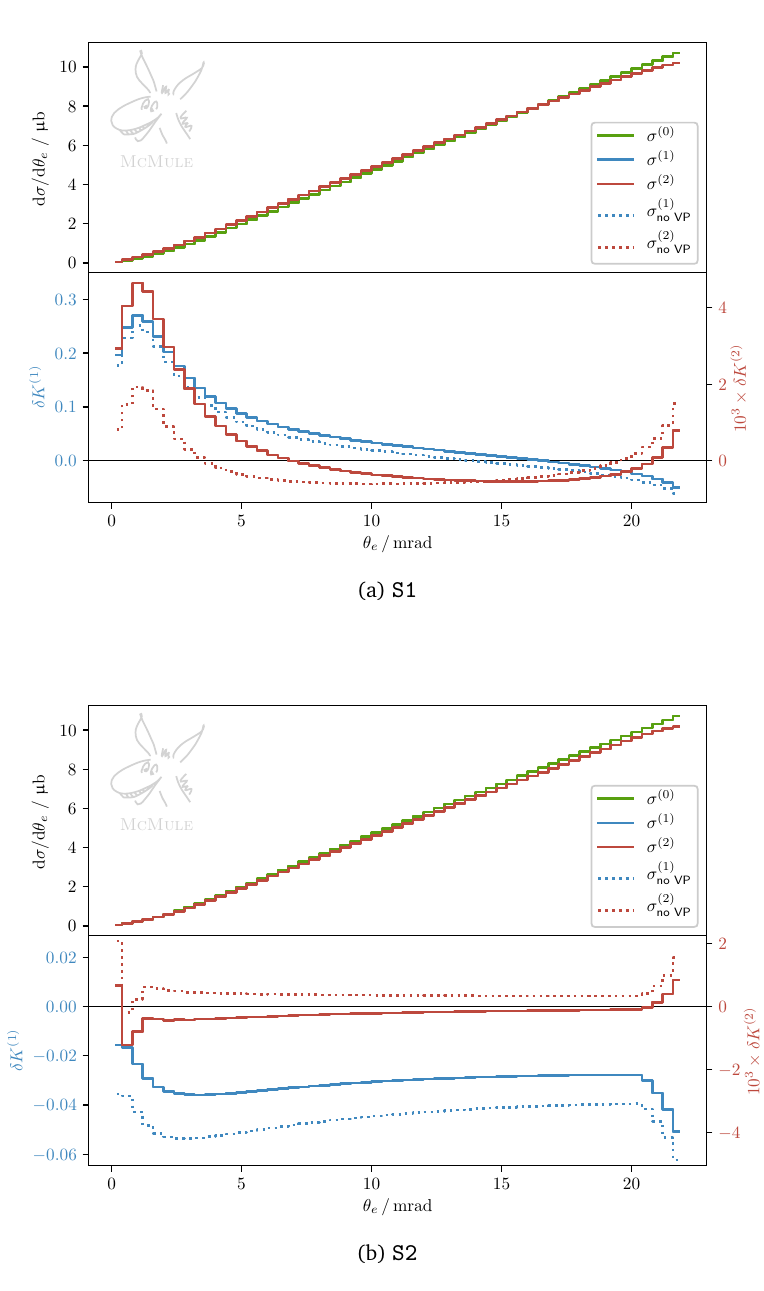
Figure 7: The differential cross section w.r.t. θ scenarios S1 (without elasticity cut) and S2 (with elasticity cut). The NLO and NNLO K factors are shown in blue and red,